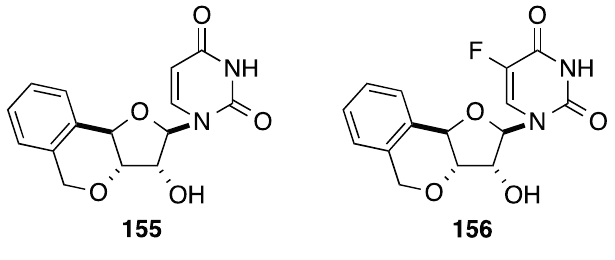
Figure 8. Isochroman derivatives 155 and 156